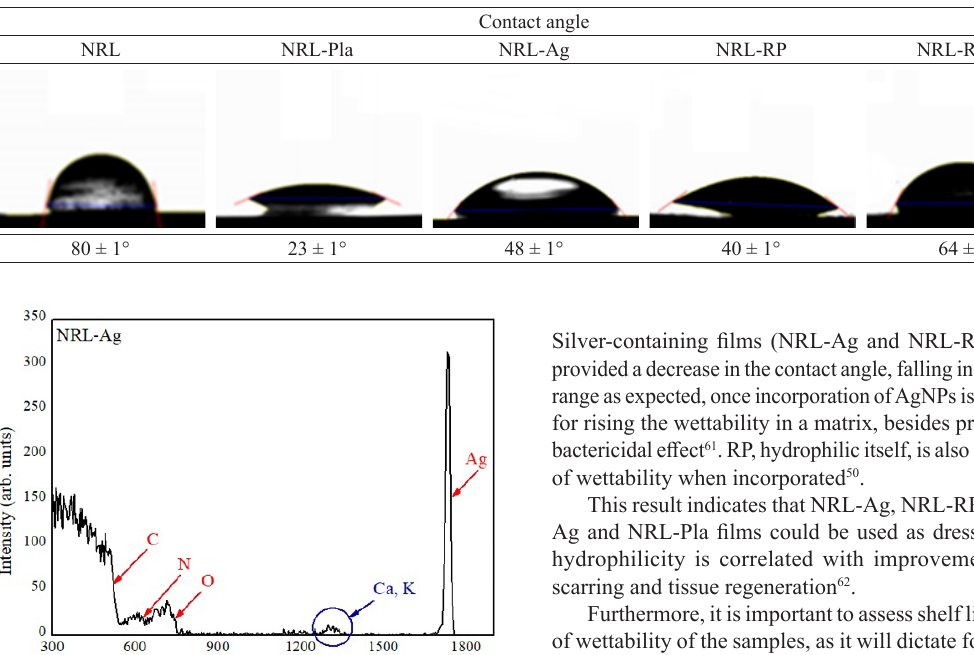
Table 4. Contact angle measurements for NRL, NRL-Pla, NRL-Ag, NRL-RP and NRL-RP-Ag films.